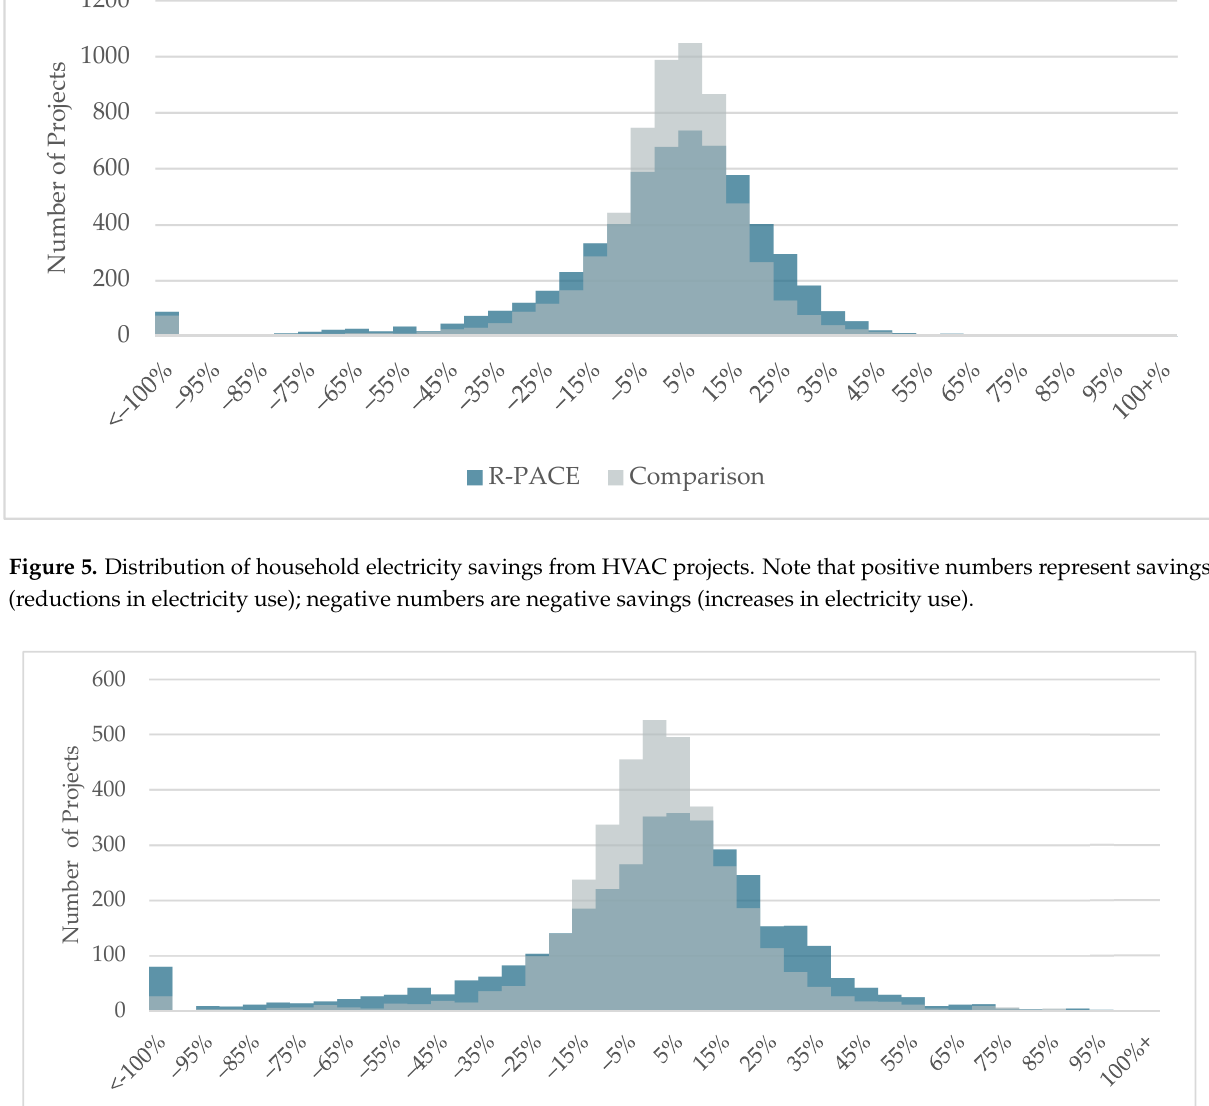
Figure 6. Distribution of household gas savings from HVAC projects. Note that positive numbers represent savings (re- ductions in gas use); negative numbers are negative savings (increases in gas use). The greater share of R-PACE households on the far left side of the distributions sug- gests that these projects installed a new furnace or air conditioning equipment and did